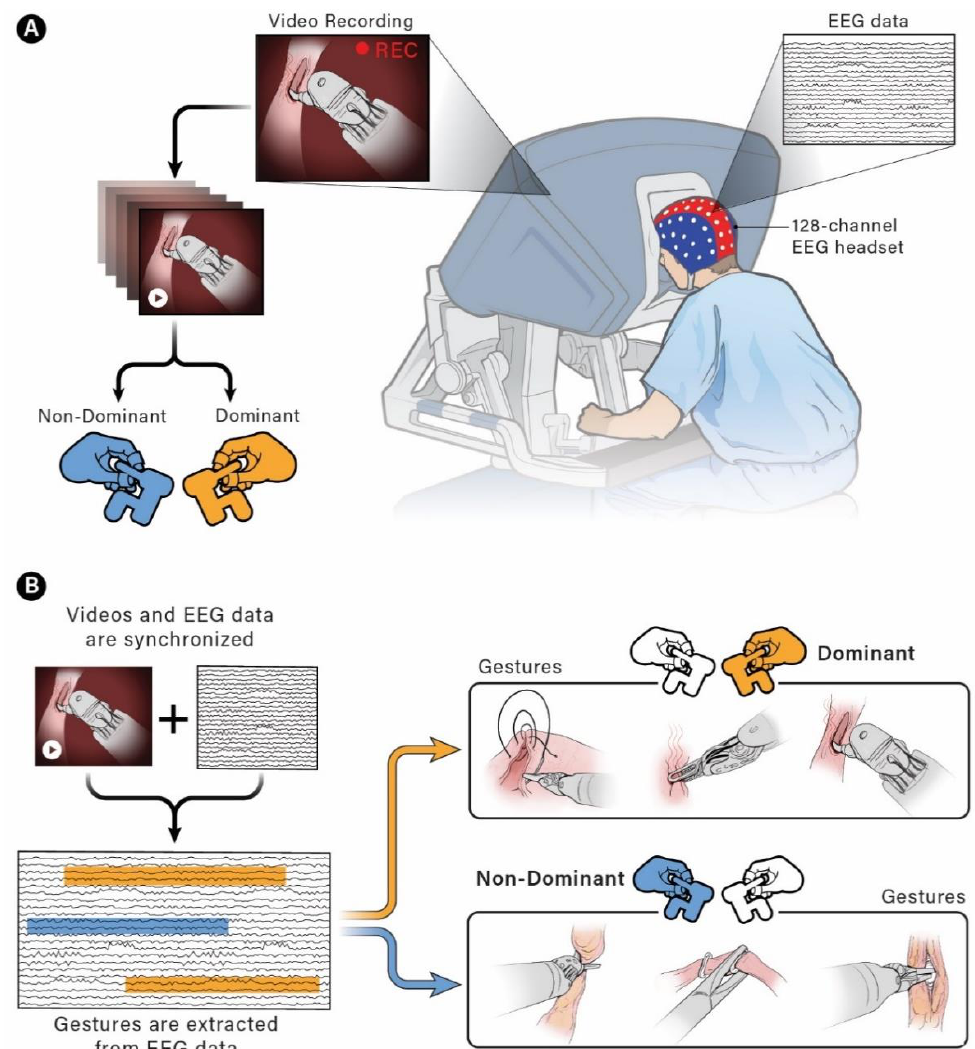
Figure 1. Schematic of experimental set up and extraction of electroencephalogram (EEG) data associated with each gesture ( A , B ) . ( A ) EEG and video data recording set up. ( B ) Synchronizing EEG data with videos to extract EEG portion associated with each gesture performed by dominant and non-dominant hands. Table 2. Extracted gestures performed by dominant and non-dominant hands. Gesture Schematic Explanation Hand